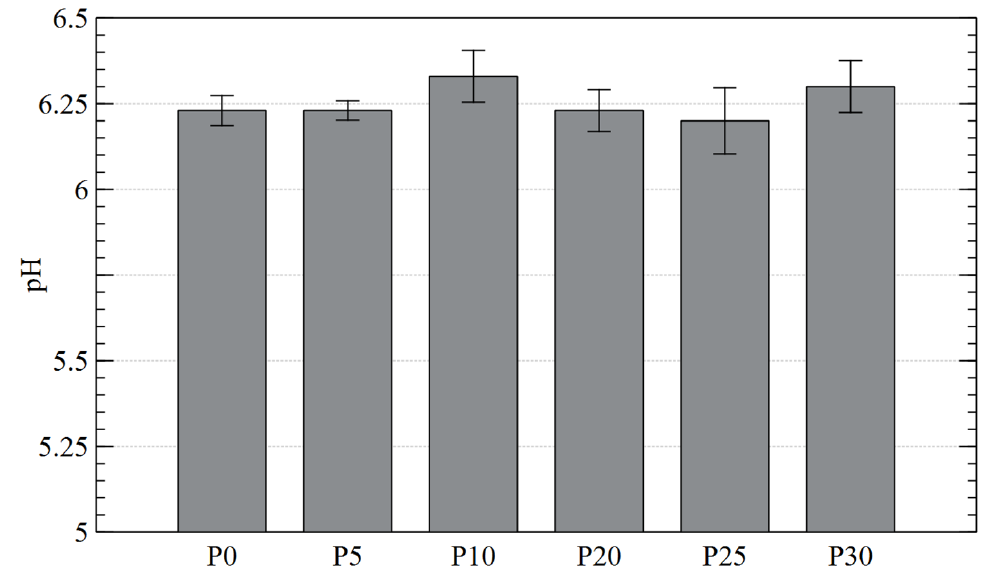
Figure 6. pH of diatomaceous earth before and after contact with plasma.